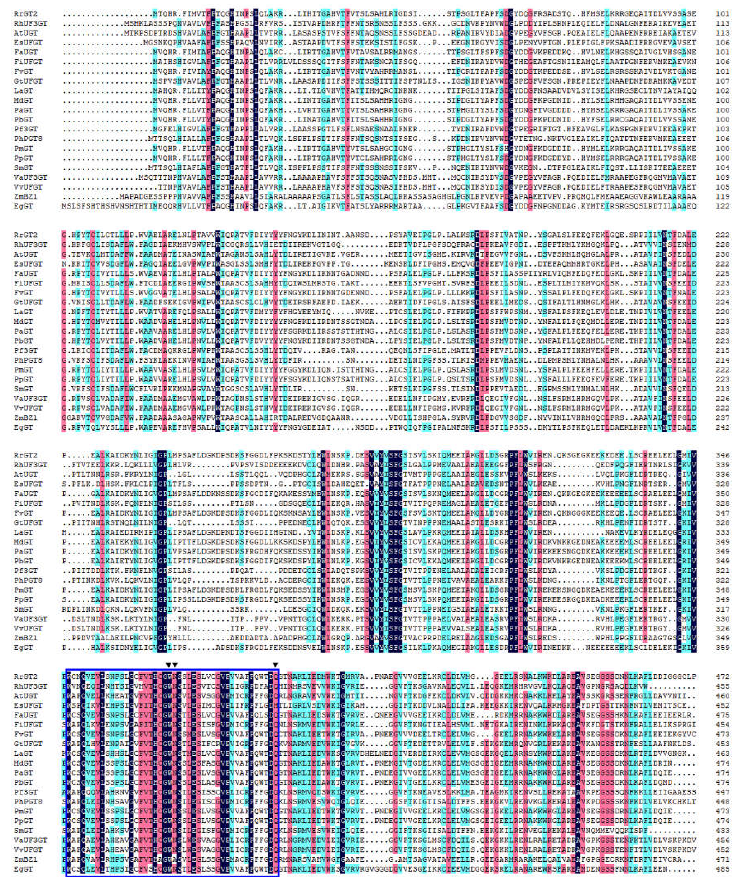
Figure 2. Amino acid sequence homology analysis of the RrGT2 gene and GTs from other species. Alignments were performed using DNAMAN (version 6.0). The blue box shows the PSPG domains. The black triangles (from left to right) indicate the 22nd, 23rd and 44th amino acids in the PSPG box. The accession numbers are the same as those in Figure 1B.